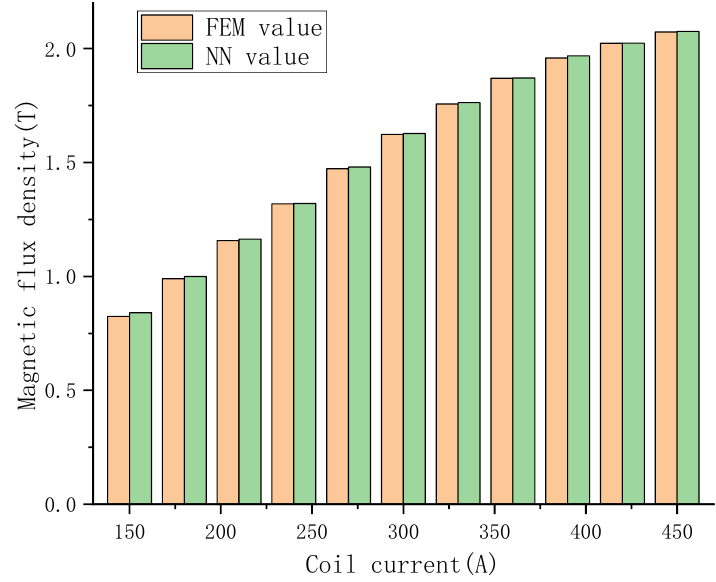
Figure 15. Comparison of magnetic flux density calculation for nonlinear